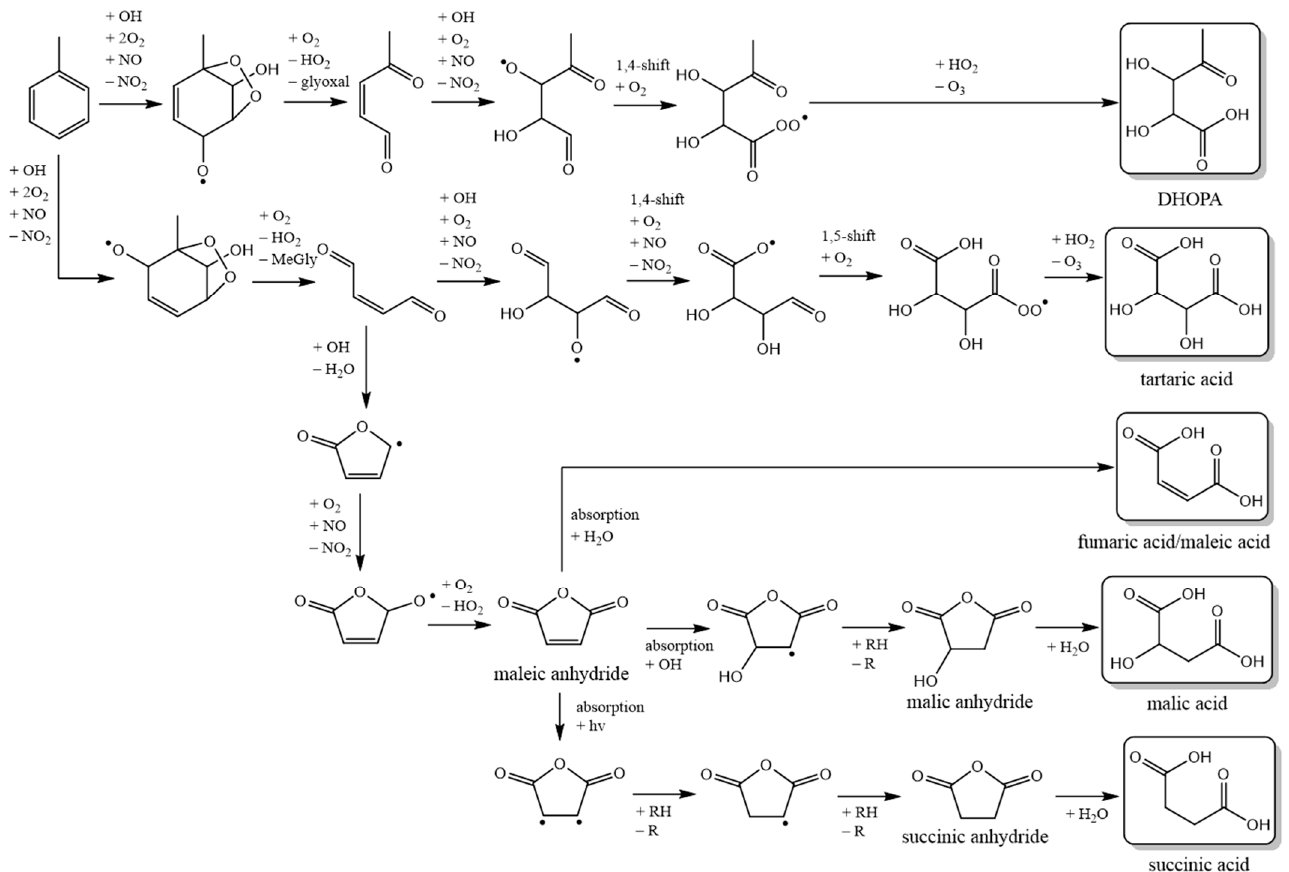
Figure 5. Formation mechanisms suggested for four- to five-carbon multifunctional carboxylic acids from the toluene photooxidation. Here, DHOPA is 2,3-dihydroxy-4-oxopentanoic acid; MeGly is methyl glyoxal; absorption is the absorption from the gas phase to the particle phase, R is organic group; and h ν is photoexcitation.